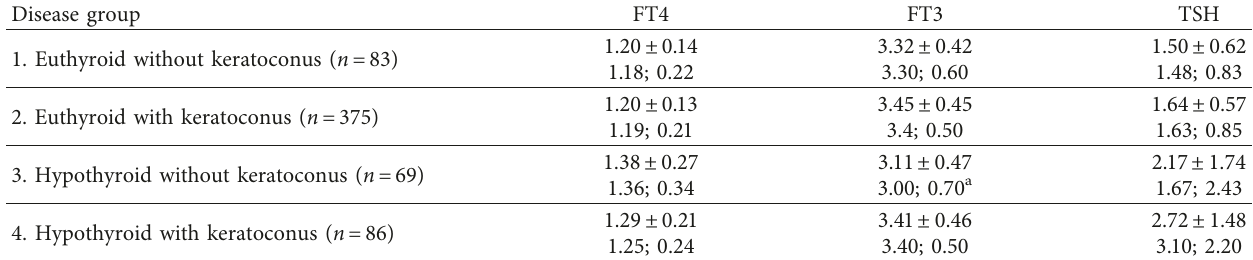
Table 1: Serum thyroid hormones: FT4 (pmol/L), FT3 (pmol/L), and TSH (mE/L) measured in different disease groups. Disease group